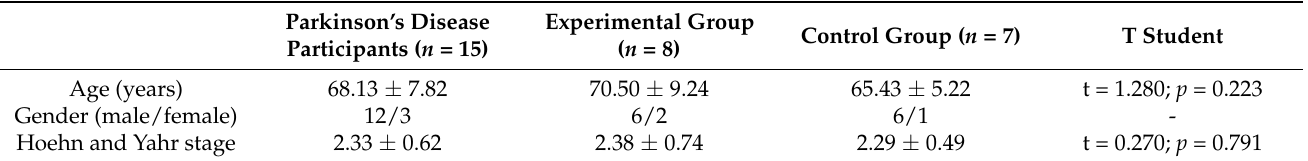
Table 1. Baseline demographics and clinical characteristics of the participants.